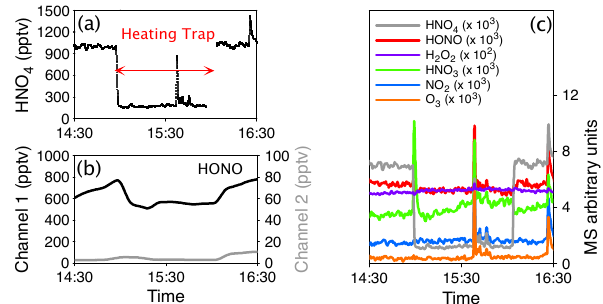
Figure 2. The experiment carried out at the PSI laboratory in or- der to investigate the interference of HNO 4 on HONO measure- ments made with the LOPAP deployed during the two Concor- dia campaigns. Left: time traces of HNO 4 (top) and of the two LOPAP channels (bottom). Time at which the heating trap was ac- tivated is shown with a red horizontal arrow. Right: intensities of NO 2 , HONO, HNO 3 , HNO 4 , O 3 , and H 2 O 2 traces as detected by the mass spectrometer (see Sect. 2.4). Heating the gas mixture to 100 ◦ C leads to a sharp decrease in HNO 4 and a small increase of HNO 3 intensities. O 3 and H 2 O 2 remain stable, whereas a very small decrease of HONO is